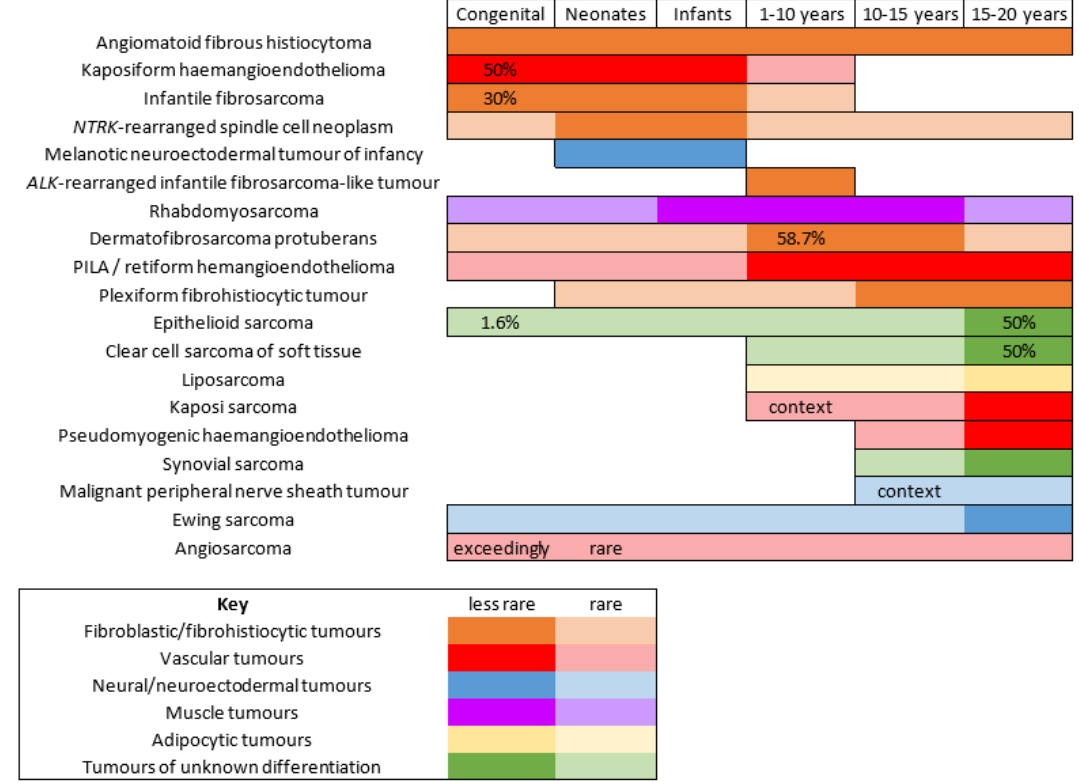
Figure 1. Malignant superficial mesenchymal tumors of the child by age range. Table 1. Genetic anomalies in pediatric malignant superficial mesenchymal tumors (tumors are listed by order of appearance in the